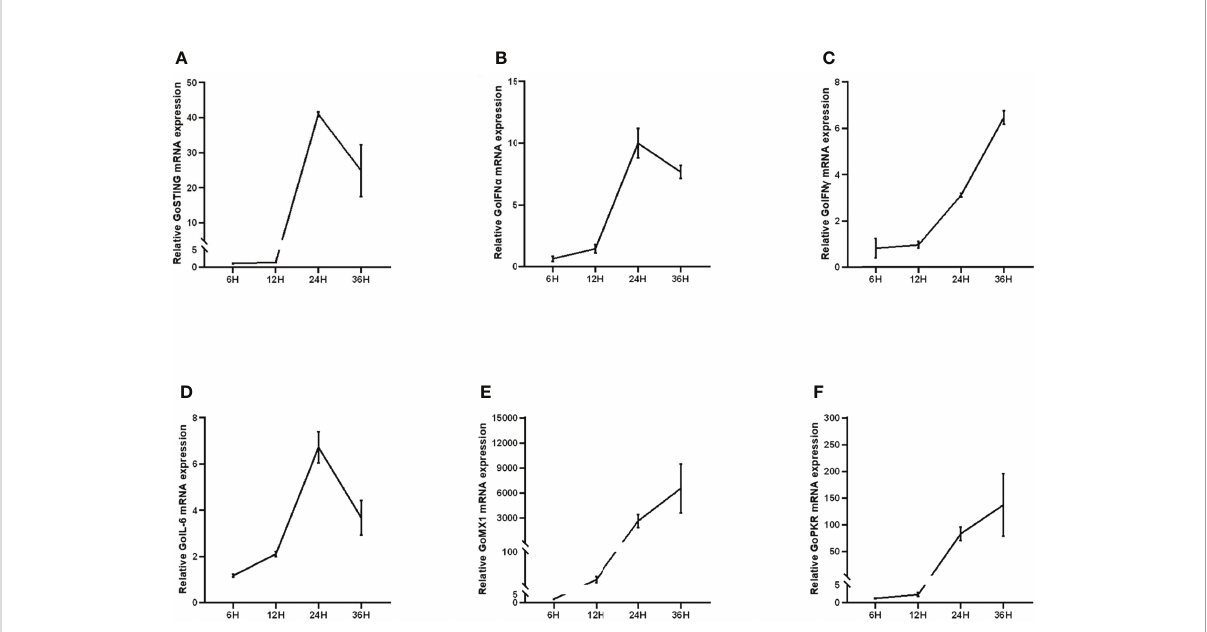
FIGURE 3 (A) Upregulation of GoSTING in GEF cells infected with NDV at 0.05 MOI. (B, C) Upregulation of IFNs (IFN- a and IFN- g ) in GEFs infected with NDV at 0.05 MOI. (D) Upregulation of IL-6 in GEFs infected with NDV at 0.05 MOI. (E, F) Upregulation of ISGs (Mx-1, PKR) in GEFs infected with NDV at 0.05 MOI. Error bars represent standard